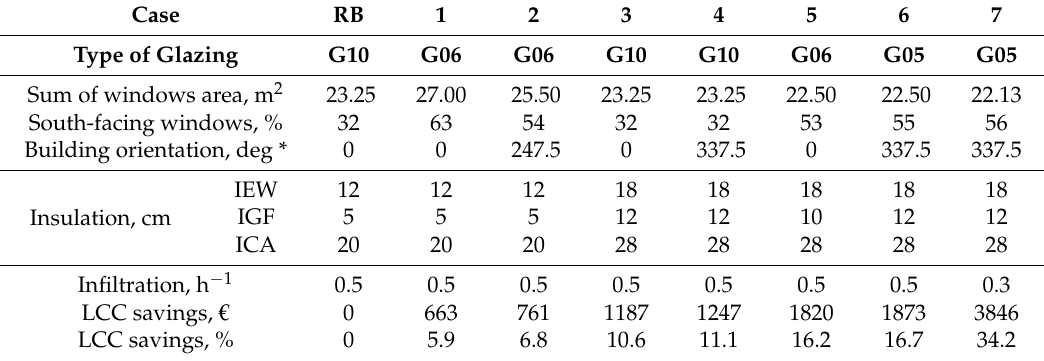
Table 11. Life cycle cost savings in optimized cases of the building with heating and cooling systems. Case